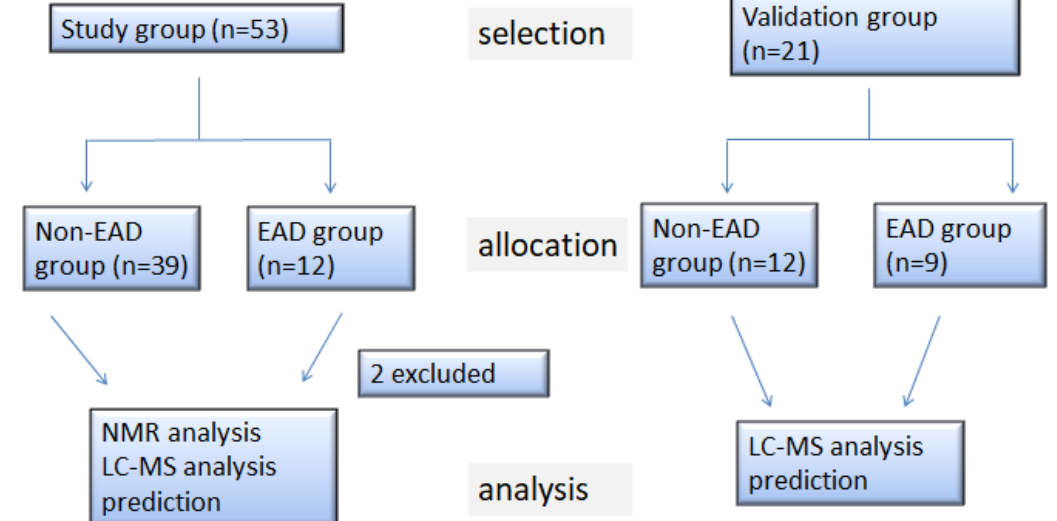
Figure 1. Flow diagram of the patient selection, allocation and analysis. HCC, hepatocellular carcinoma; non-HCC, non-hepatocellular carcinoma; EAD, early allograft dysfunction; NMR, nuclear 1 H-nuclear magnetic resonance spectroscopy; LC-MS, liquid chromatography coupled with mass spectrometry.